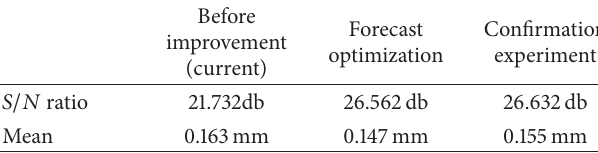
Table 7: Comparison of values before improvement (current), forecast optimization, and confirmation experiments. Before Forecast Confirmation optimization